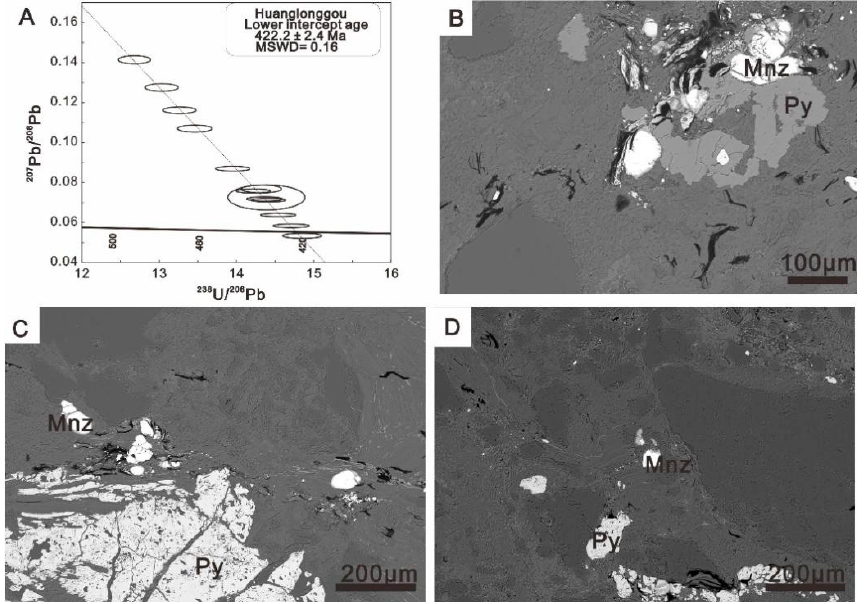
Figure 8. ( A ) The U–Pb Tera–Wasserburg Concordia diagram of monazite in the Huanglonggou deposit; ( B – D ) BSE images of typical monazite grains coexist with pyrite in stage 2 ores of the Huanglonggou deposit. Abbreviations: Mnz = monazite, Py = pyrite.